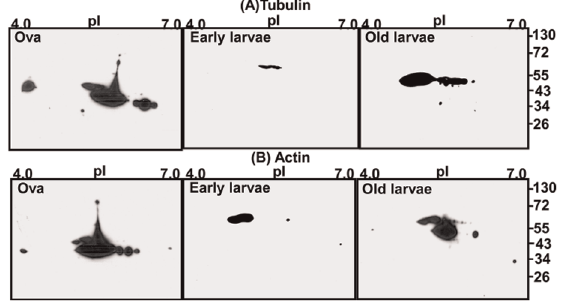
Figure 8. Two-dimensional Western blot analysis of tubulin (A) and actin (B) in Ova, early larvae and old larval stages of Neanthesarenaceodentata .